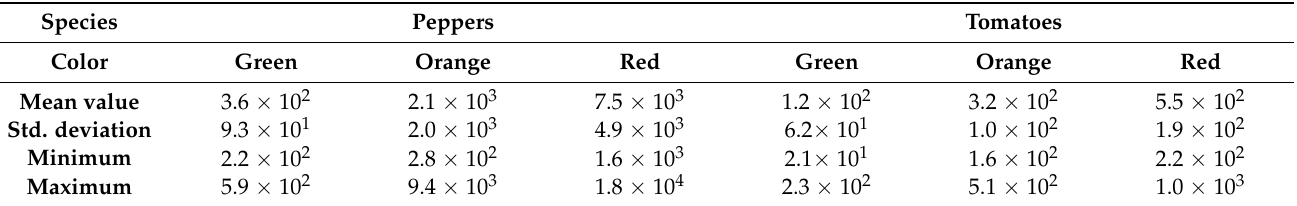
Table 1. Inter-fruit variations of the Raman band intensities at 1500 cm − 1 within 10 fruits of each category (green, orange and orange/red, red, see below) and species. Species Peppers Tomatoes Color Green Orange Red Green